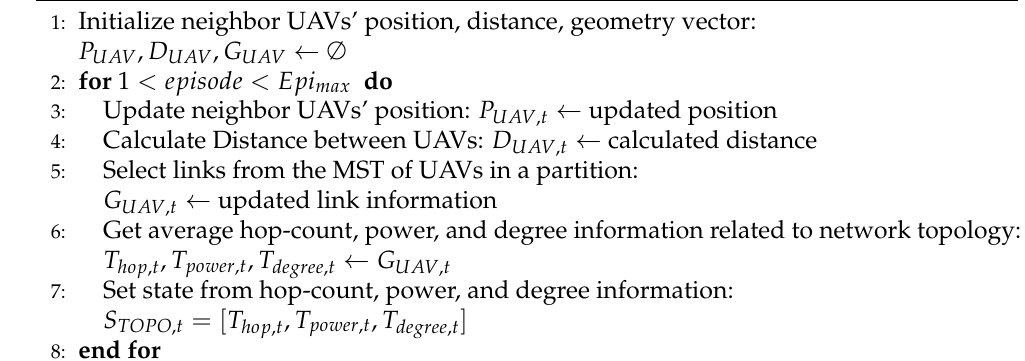
Algorithm 1 Network Topology Control